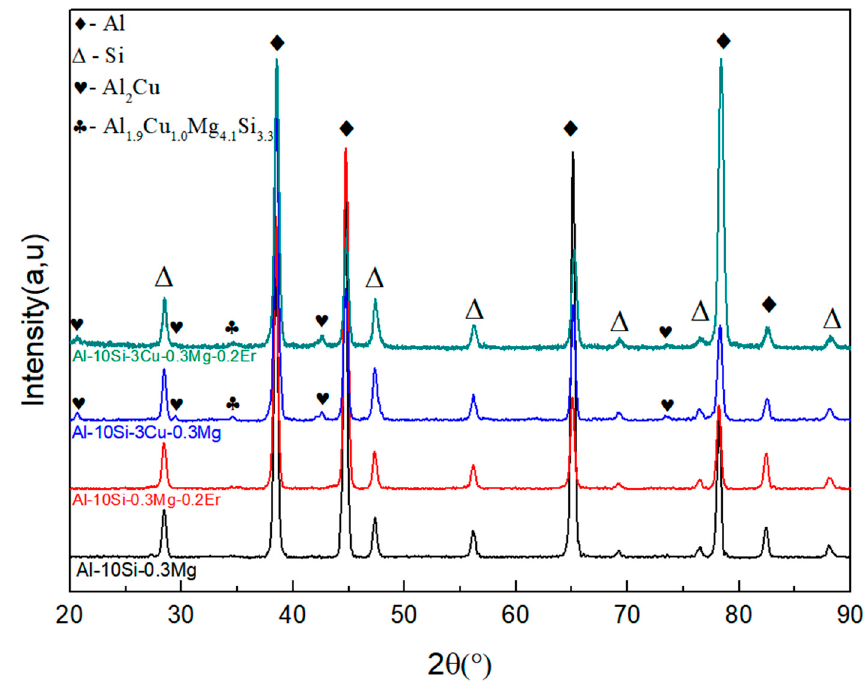
Figure 3. XRD patterns of Al-Si alloys with different compositions.